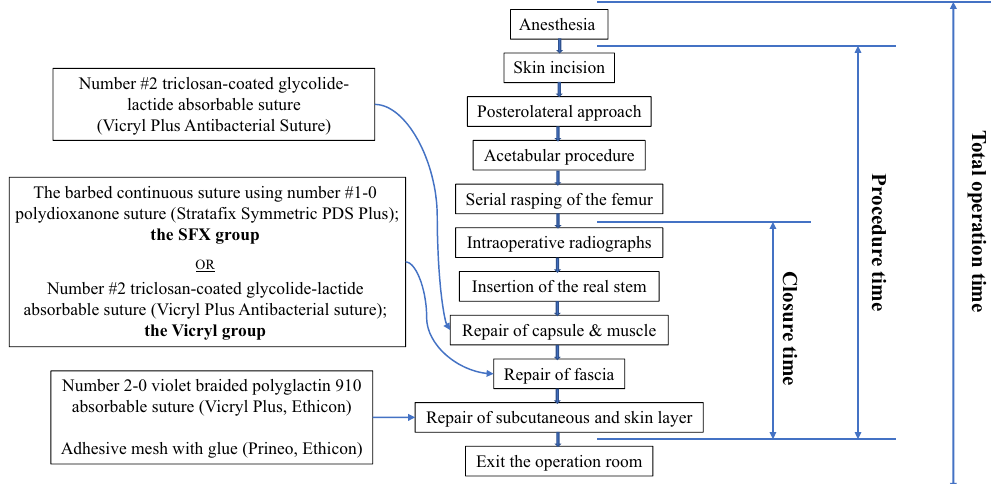
Figure 1. A flowchart for the surgical procedure, suture methods, and time